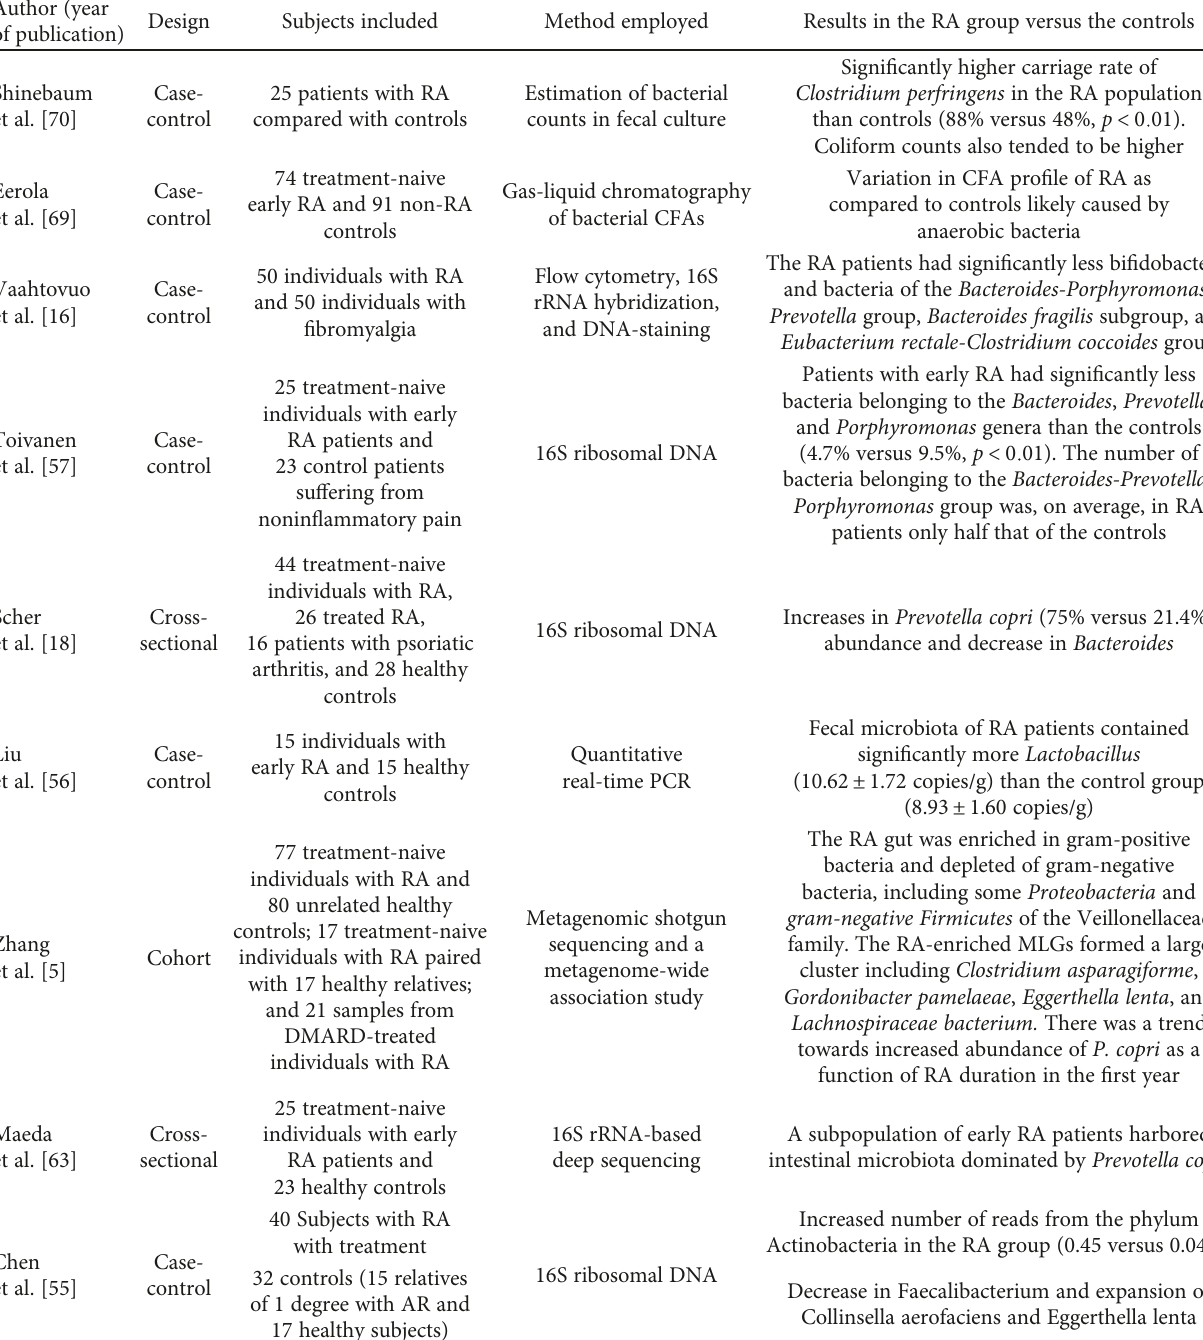
Table 2: Summary of studies that have evaluated the in fl uence of gut fl ora on the etiopathogenesis of